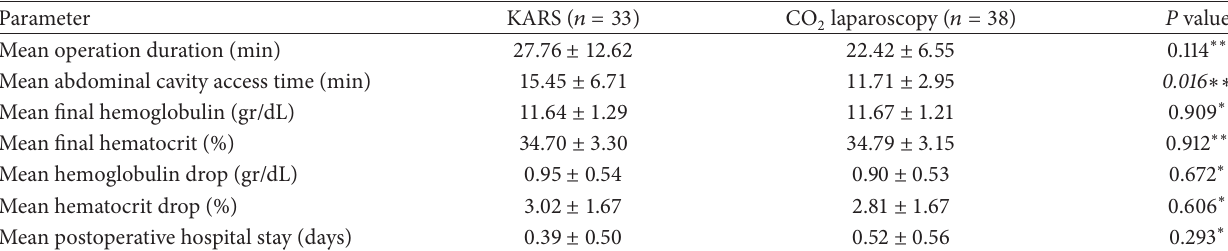
Table 2: The intraoperative and postoperative findings of the study according to the operative techniques. The data was presented with mean ± standard deviation